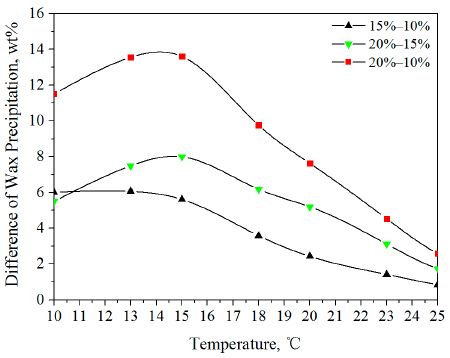
Figure 6. The difference in wax precipitated at different temperatures.